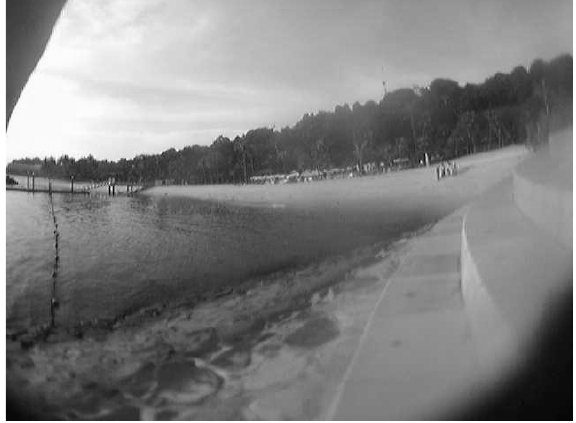
Figure 5. Sample SenseCam lifelog image from event at Sentosa Island, Singapore.